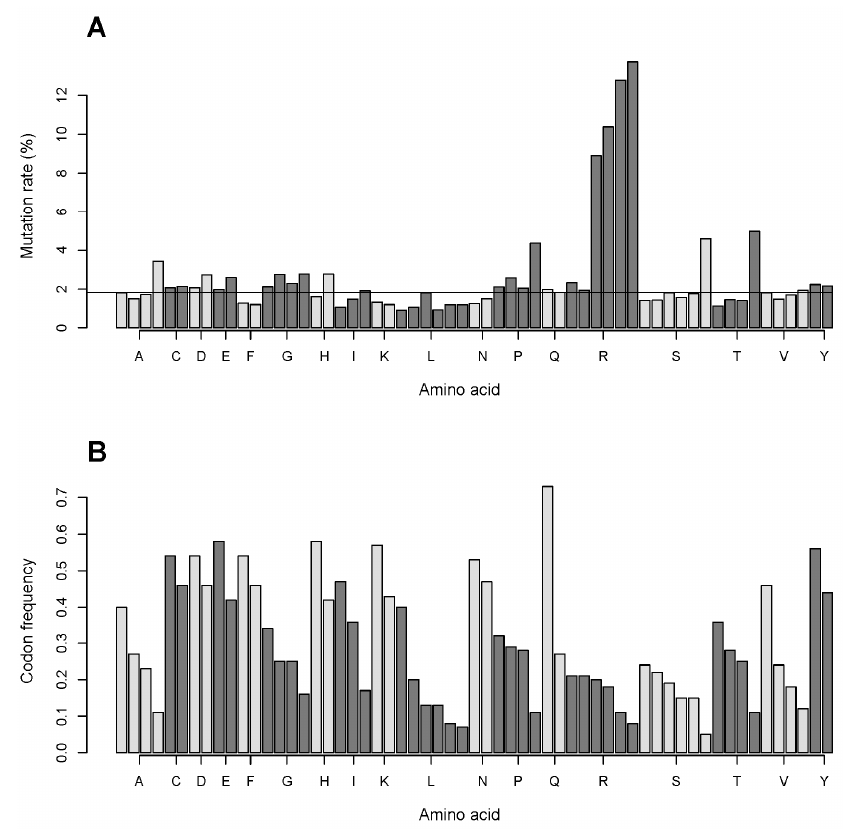
Figure 8. Mutation rates for codons that represent each amino acid. ( A ) The mutation rates were calculated as ratios of mutation events in the codon in the CCLE data to the number of the codon in the analyzed genes determined from the data on the codon frequencies in the human proteome [8] . The mutation rate bars for each codon are positioned according to the respective frequencies of the codons in Graph B. ( B ) Codon frequencies are ranked in the descending order for codons of each amino acid (Table S1). In both graphs, bars pertaining to each amino acid are alternately represented in dark grey and light grey for convenience of perception.